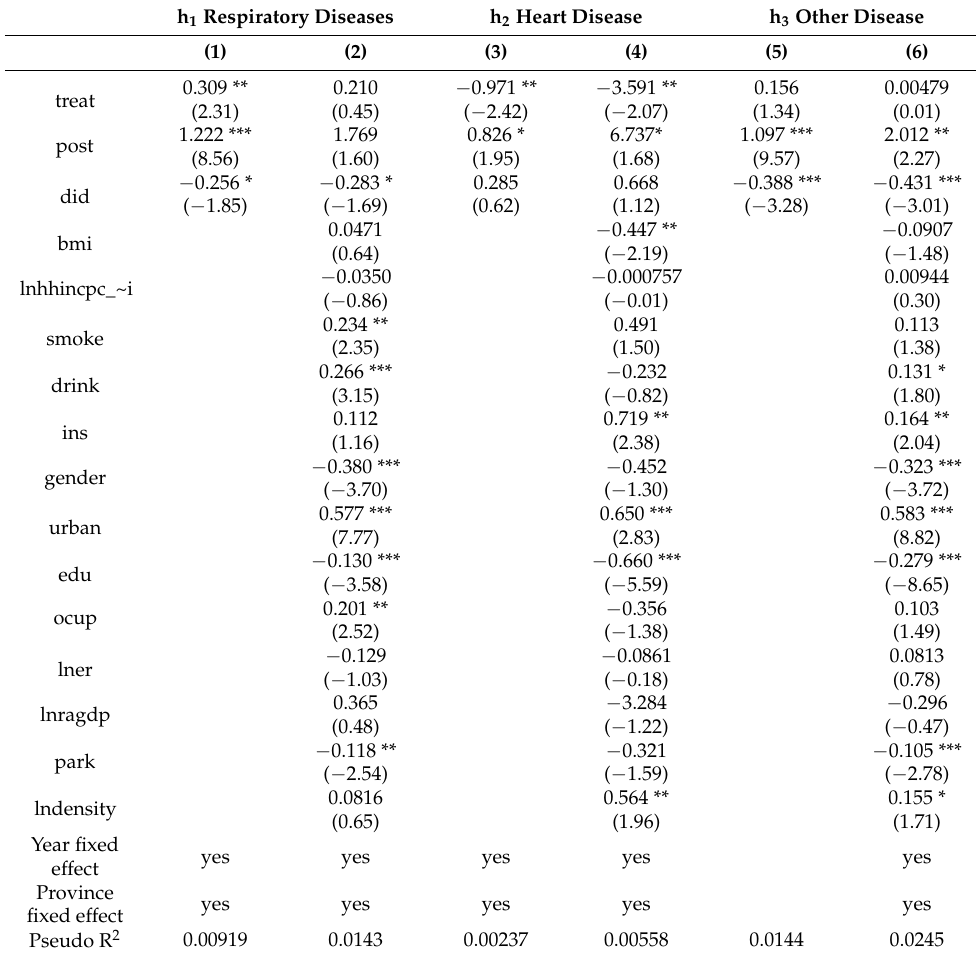
Table 3. Baseline empirical results of health